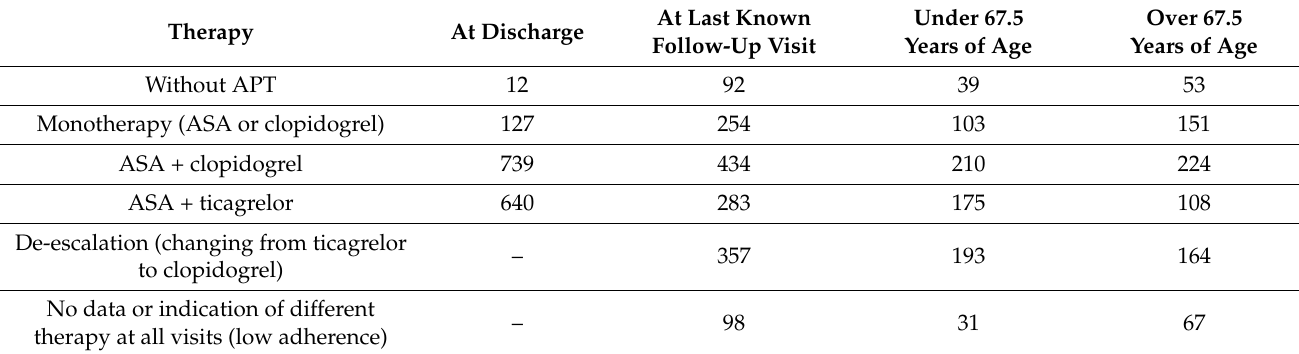
Table 2. Antiplatelet therapy (APT) at hospital discharge and the last known follow-up